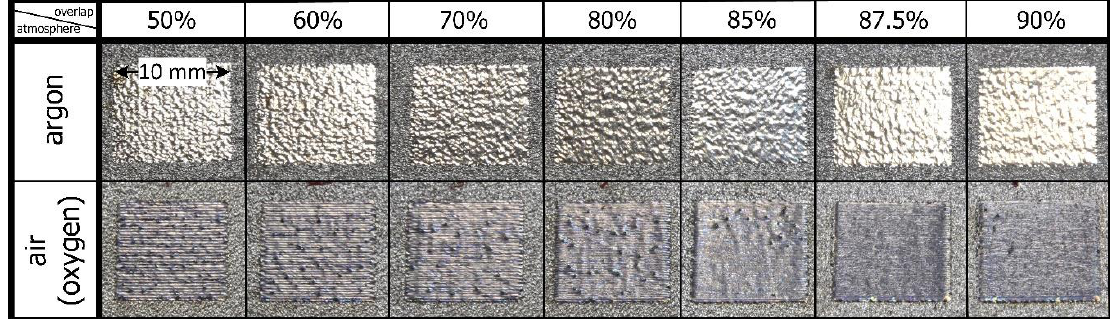
Figure 3. Physical appearance of the laser polished samples, proceeding in accordance with Table 2.